Question: Is the quantity shown trending increasing or decreasing?
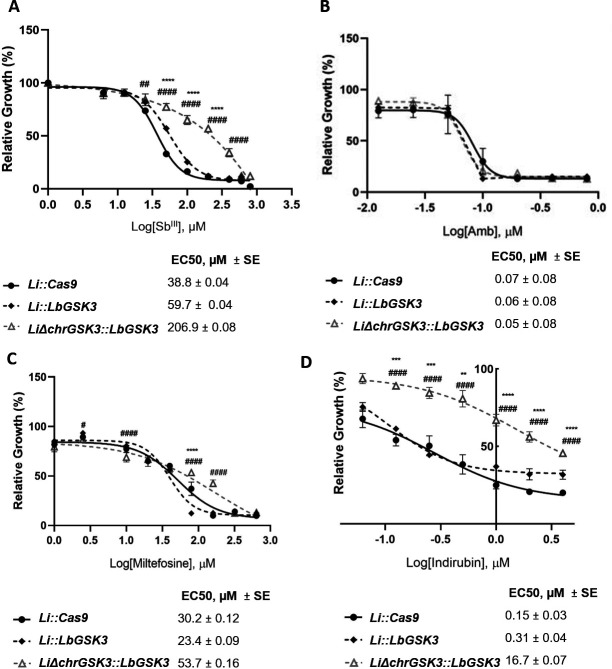
Answer: increasing